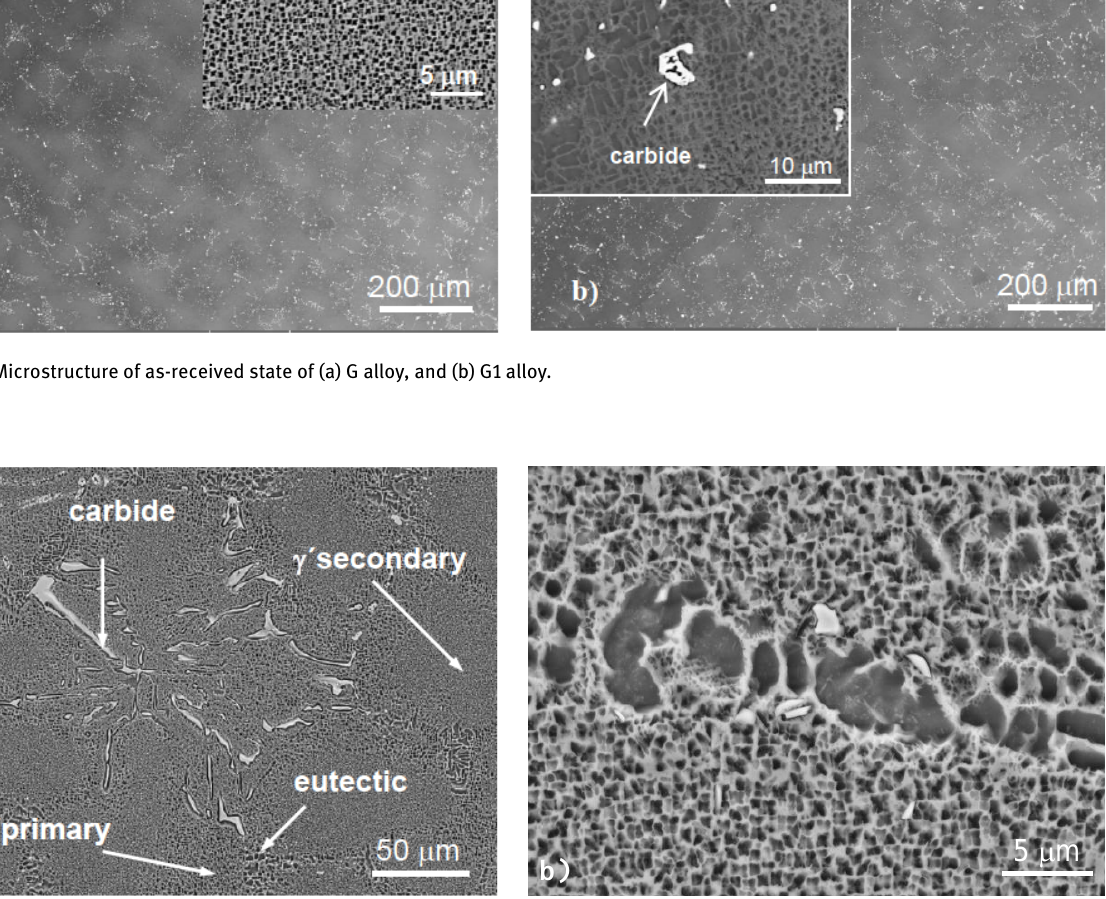
Figure 3: Microstructure of alloy G crept at 800 ∘ C and 400MPa at different magnification.